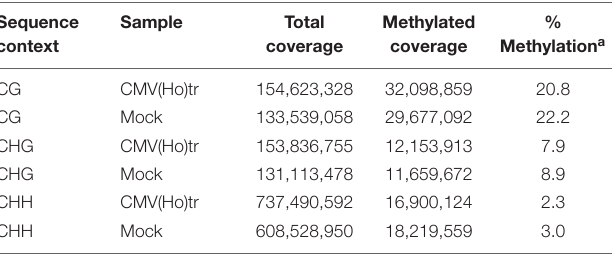
TABLE 1 | Methylation coverage and ratio of every single cytosine in CG, CHG, and